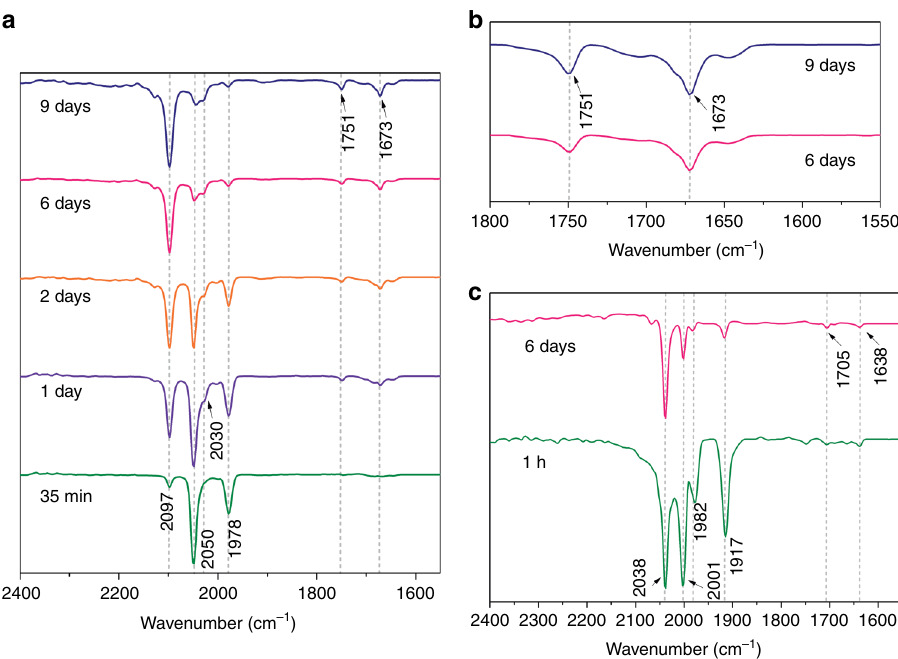
Fig. 2 IR spectroscopic monitoring of the reaction between 1 Mes and carbon monoxide. a IR spectra in toluene at room temperature obtained from the reaction of 1 Mes with CO; an aliquot was taken from the reaction mixture at the indicated times, dried under vacuum for ca. 1 h and dissolved in toluene. b Zoom of a between 1800 and 1550 cm – 1 ; spectra recorded at 6 days and 9 days. c IR spectra in toluene at room temperature obtained from the reaction of 1 Mes with 13 CO; an aliquot was taken from reaction mixture at the indicated times, dried under vacuum for ca. 1 h and dissolved in toluene